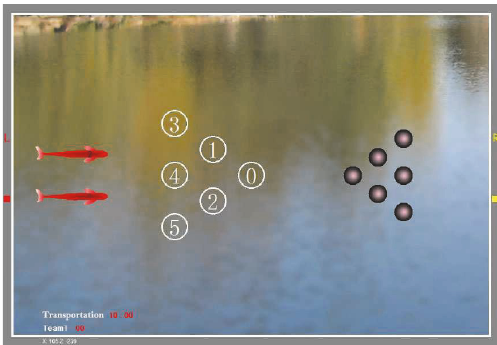
Figure 6: The field of Underwater Transport